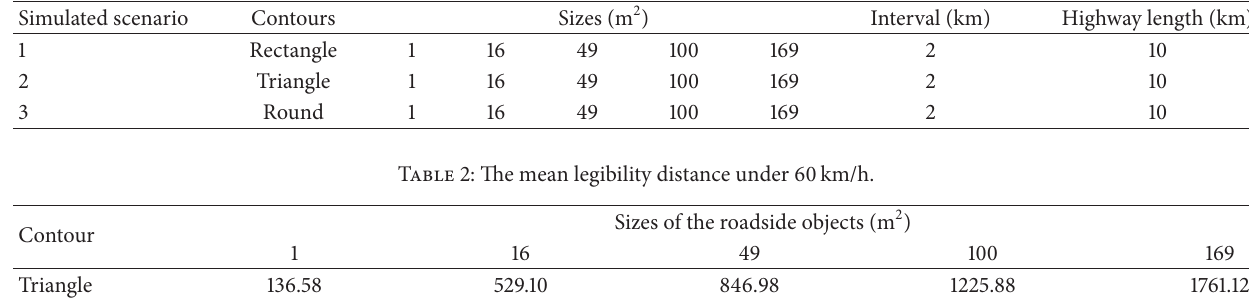
Table 1: The design parameters of the roadside objects.